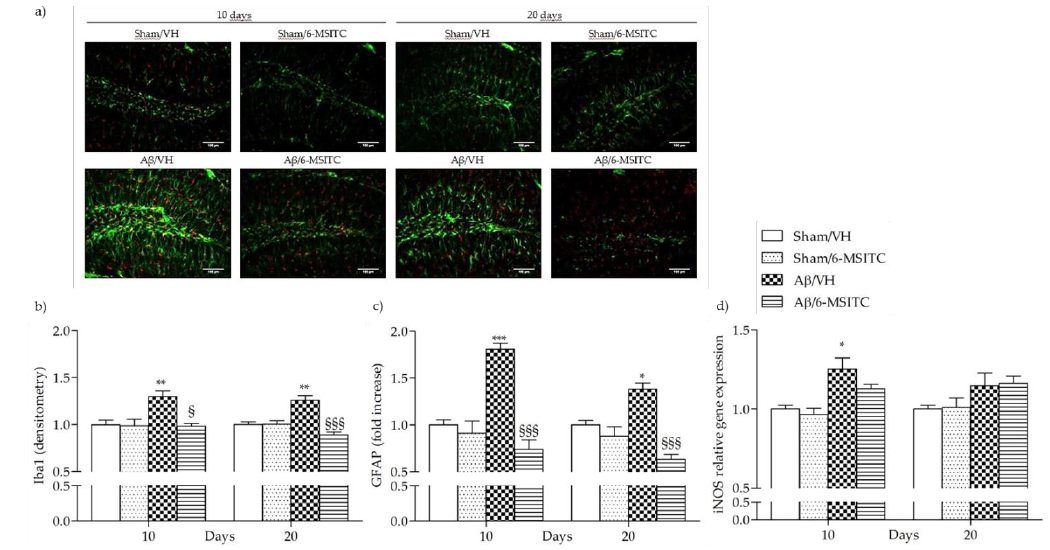
Figure 9. Effects of 6-MSITC (5 mg/kg) on inflammatory response after A β 1-42 O injection. Representative photomicrographs ( a ) of immunostaining for GFAP (green) and Iba1 (red) at 10 and 20 days post A β 1-42 O injection in brain coronal sections containing hippocampal structure. Magnification 20 × , scale bar 100 µ m. Quantitative analysis of GFAP ( b ) and Iba1 ( c ) immunostaining. Values are expressed as mean of fold increase ± SEM ( n = 10) of the fluorescent intensity of each experimental group compared to the Sham/VH group. iNOS mRNA relative expression ( d ) was determined in hippocampal samples 10 and 20 days after A β 1-42 O injection through the 2 − ∆∆ Ct method ( b : ** p < 0.01 vs. sham groups, § p < 0.05 and §§§ p < 0.001 vs. A β /VH group; c : * p < 0.05 and *** p < 0.001 vs. sham groups, §§§ p < 0.001 vs. A β /VH group; d : * p < 0.05 vs. sham group; ANOVA, post hoc test